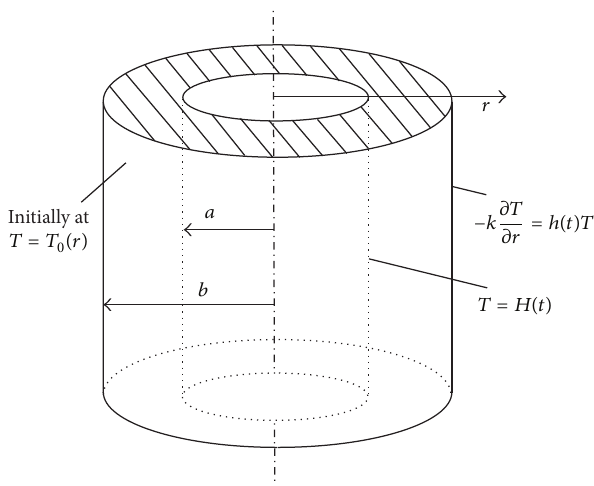
Figure 1: Hollow cylinders with time-dependent temperature and time-dependent heat transfer coefficient at inner and outer